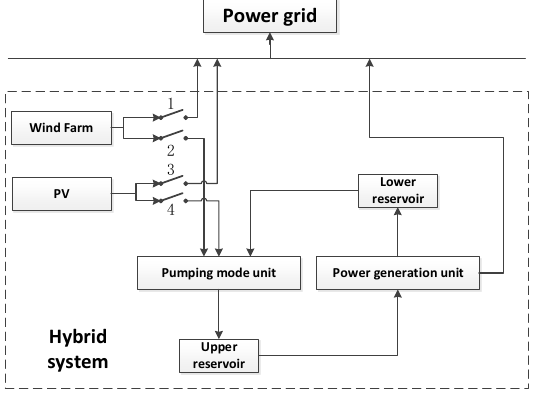
Figure 1. Structure of the hybrid renewable energy system. PV: photovoltaics.